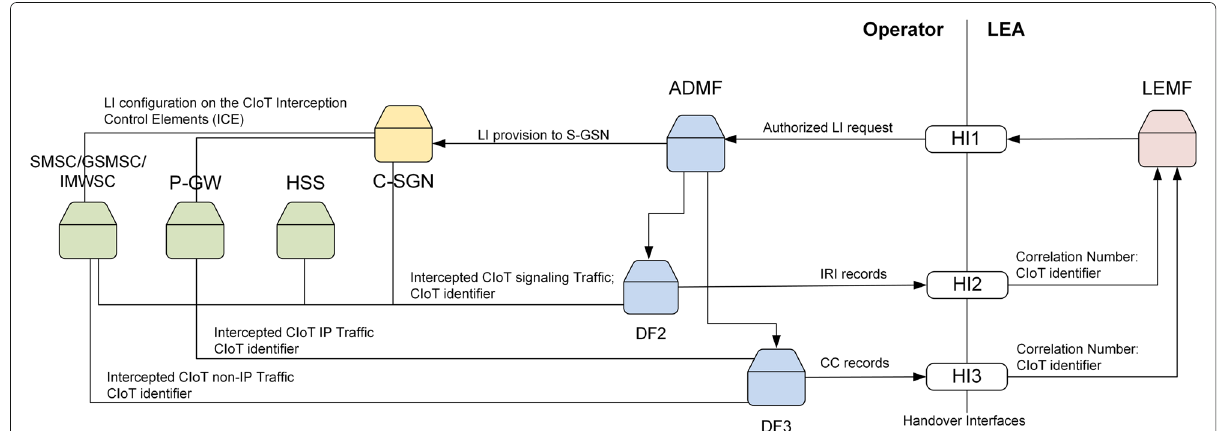
Fig. 15 LI integration with the CIoT architecture. For the LEA to be able to distinguish and correlate CIoT traffic (signaling and both IP and non-IP traffic), a CIoT identifier is